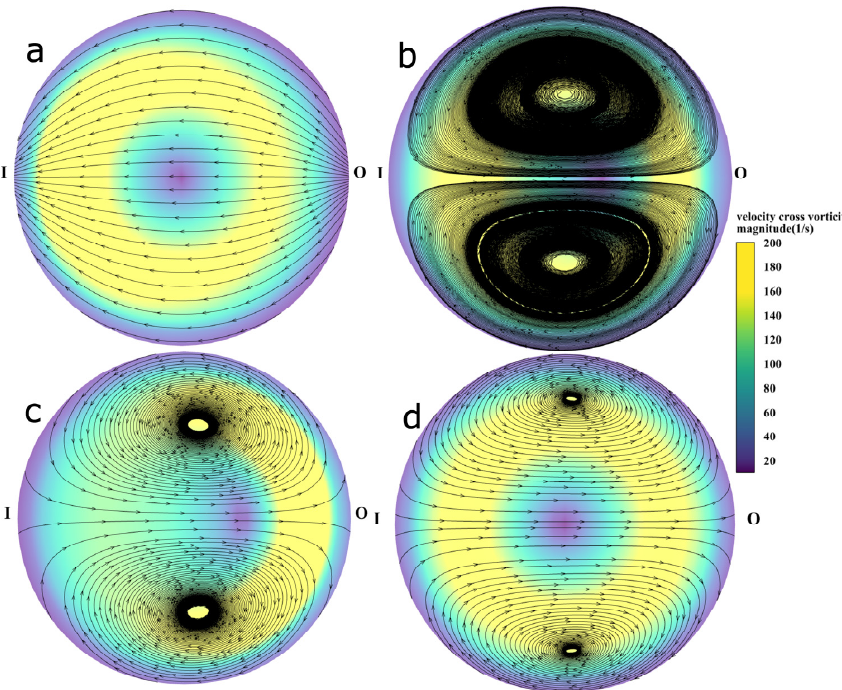
Figure 15. In the 90° channel at the conveying rate of 2.85 cm 3 /s, ( a – e ) are the profiles of the velocity magnitude and the velocity vectors on the five slices as indicated in Figure 2a.